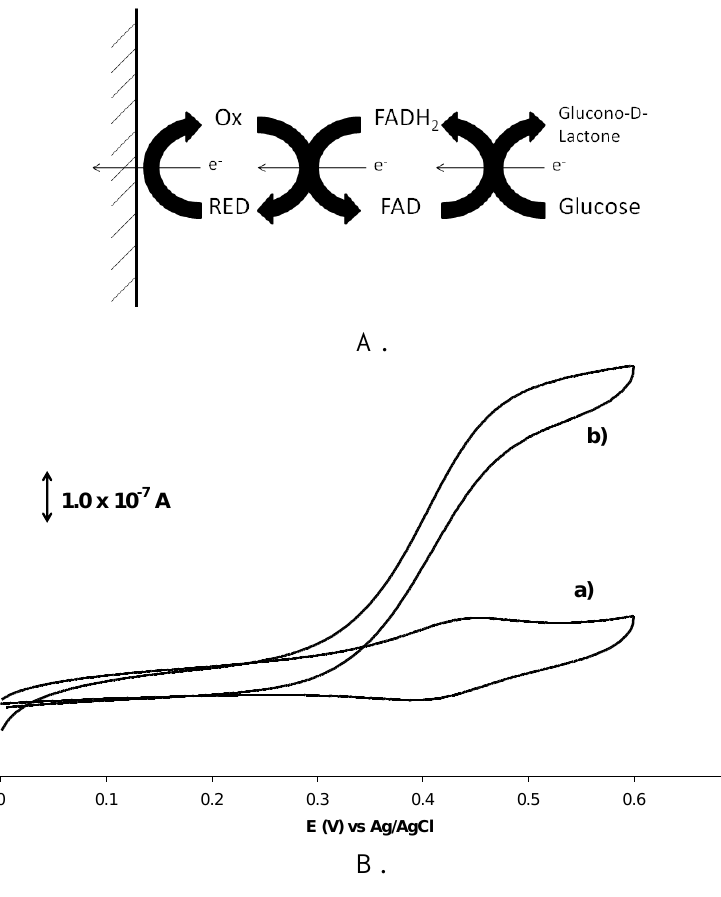
Figure 1. A. Schematic diagram of the redox mediation scheme. Glucose in the presence of Glucose oxidase is oxidized to Gluconolactone and the redox active FAD site in the enzyme is reduced to FADH . The FADH can be oxidized back to FAD by reducing the 2 2 redox mediator. The reduced form of the redox mediator is returned to the oxidized form by the heterogeneous electrode reaction. The current measured by the electrode reaction, therefore, is directly related to the amount of glucose that is oxidized by the enzyme reaction. B. (a) current response of the redox mediator in the absence of glucose, and (b) Steady state current response from the redox mediator in the presence of glucose [27]. (Alice C. Harper and Mark R. Anderson, ―Electrostatic Assembly of a Redox Catalysis System for Detection of Glutamate‖, Electroanalysis, 2006. Copyright Wiley-VCH Verlag GmbH & Co. KgaA. Reproduced with